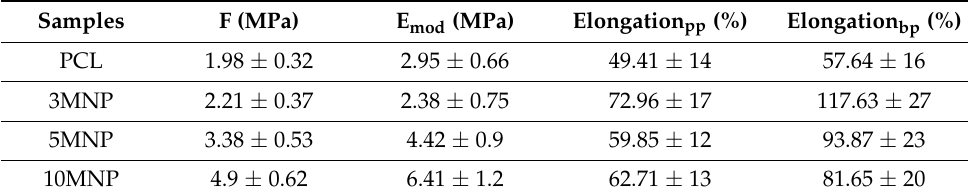
Table 2. Mechanical properties of fibrous